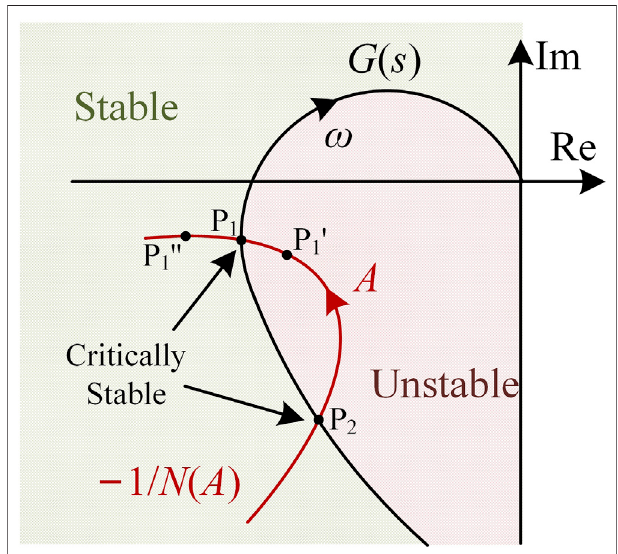
FIGURE 2 | Stability analysis based on the extended Nyquist